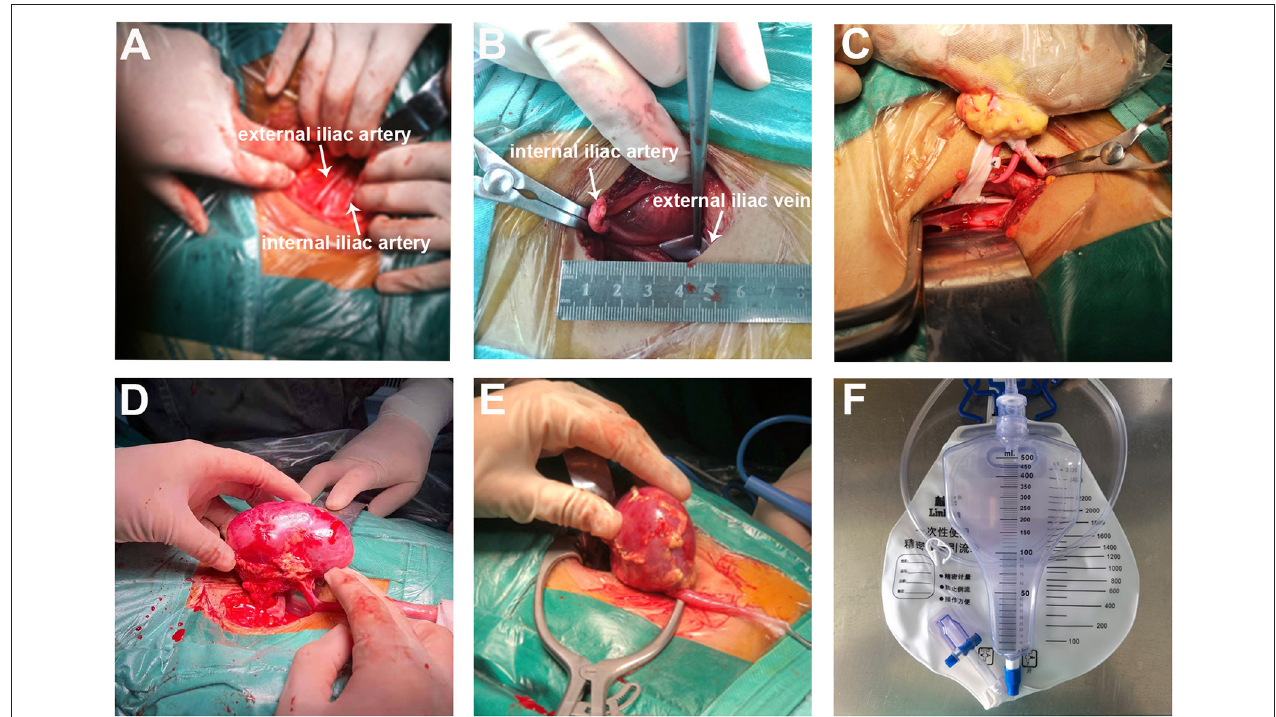
FIGURE 3 | The SMIPKT surgical technique. (A,B) Full exposure with minimal dissection of the external iliac artery (white arrow), iliac artery (white arrow), and the external iliac vein (white arrow). (C) The two vascular anastomoses were performed with renal graft in a custom-made ice bag wrapped in ice sludge. (D) Minimal incision can be smaller than the kidney. (E) The upper pole of renal graft was placed into the iliac fossa at first. (F) Blood loss and postoperative drainage volume are precisely measured through a self-control precision metering drainage bag.